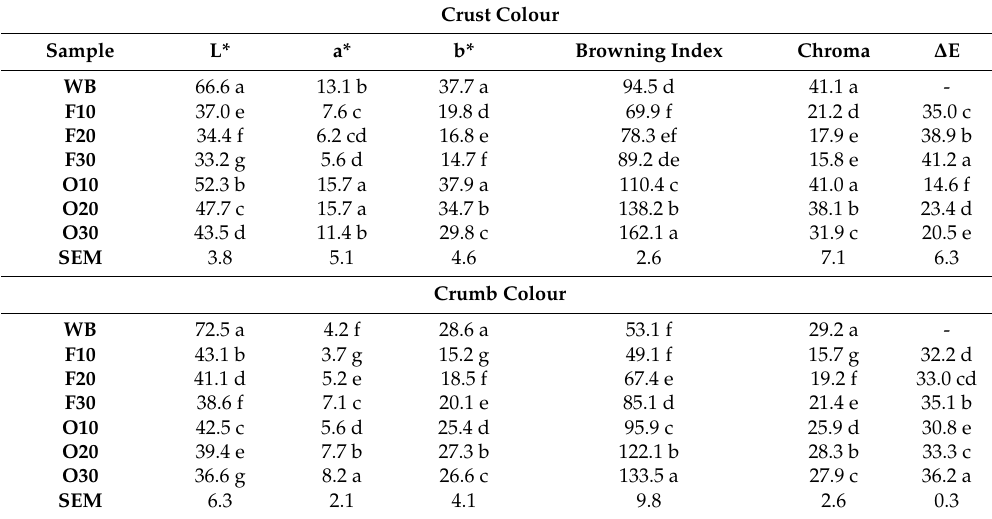
Table 2. Colour parameters of bread crust and